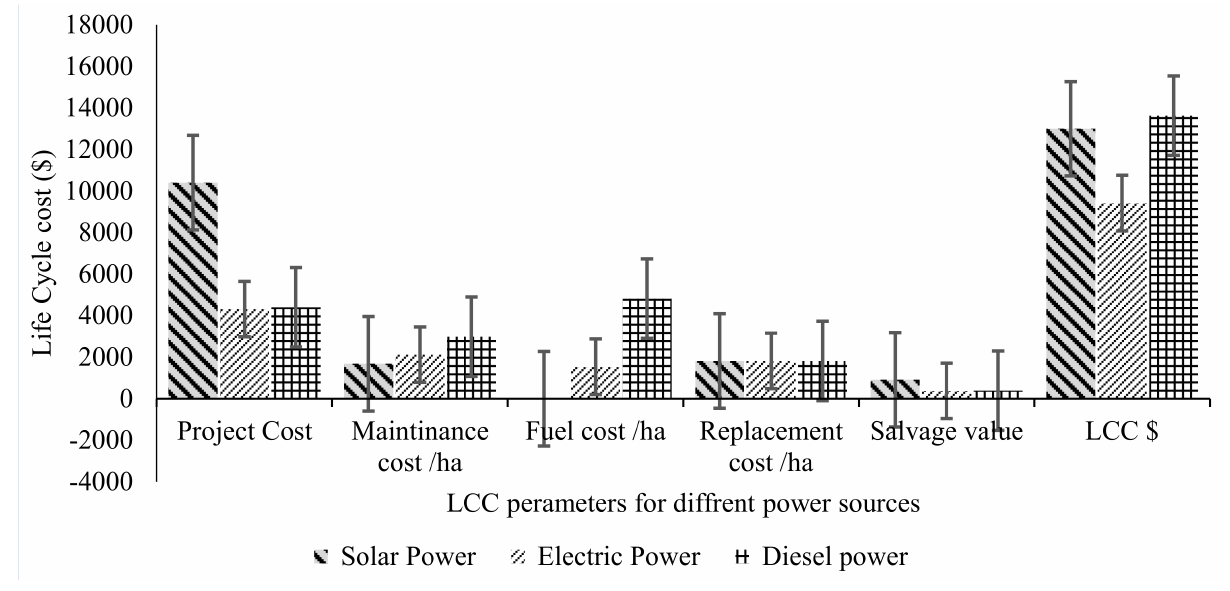
Figure 10. LCC parameters for different power sources for